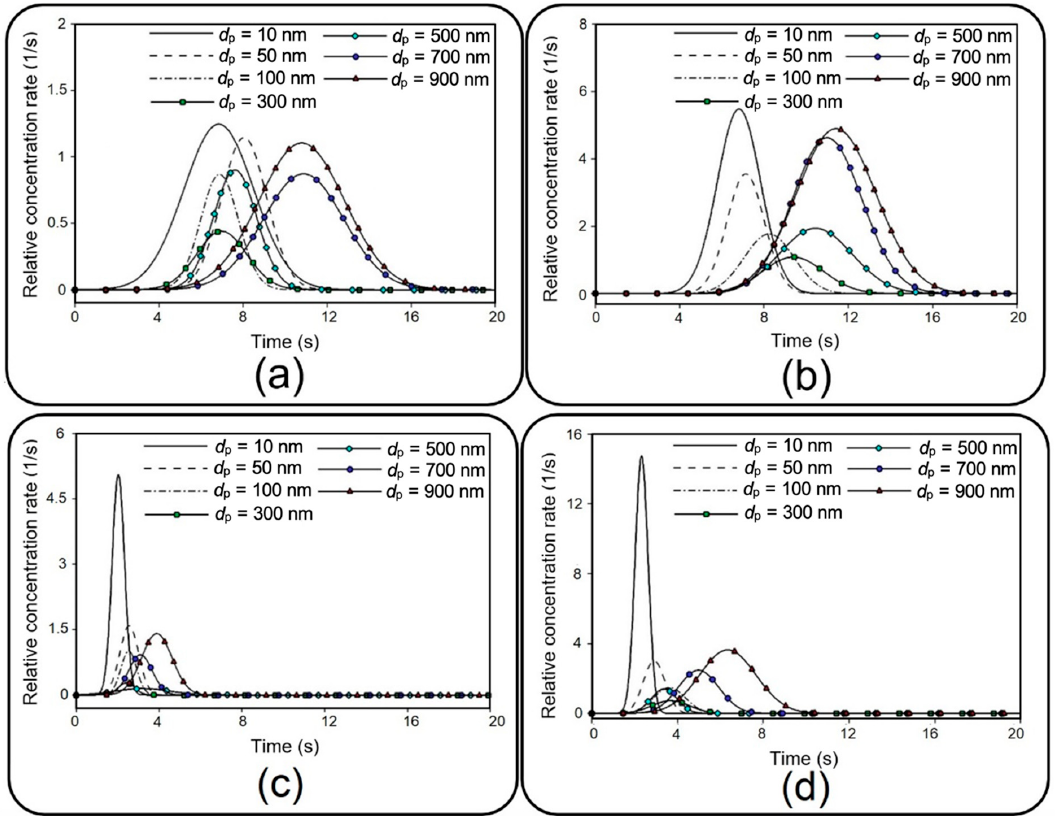
Figure 14. Snapshots from transient distribution of particles with a diameter of 10 nm in the lung-on-a-chip device with pore diameter and pore-to-pore distance of 10 µm and fluid velocity of 0.3 mm/s.